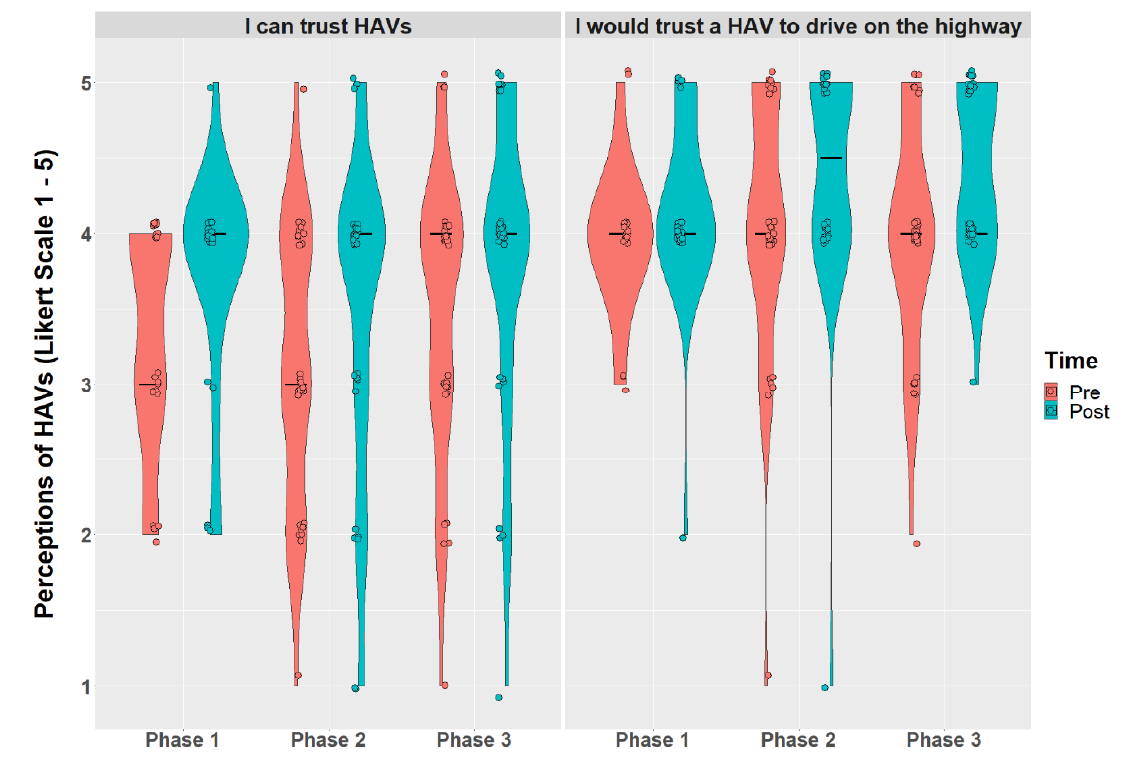
Figure 3. Violin plot with jitter and median line displaying trust and situational trust before and after riding in the shuttle between phases.